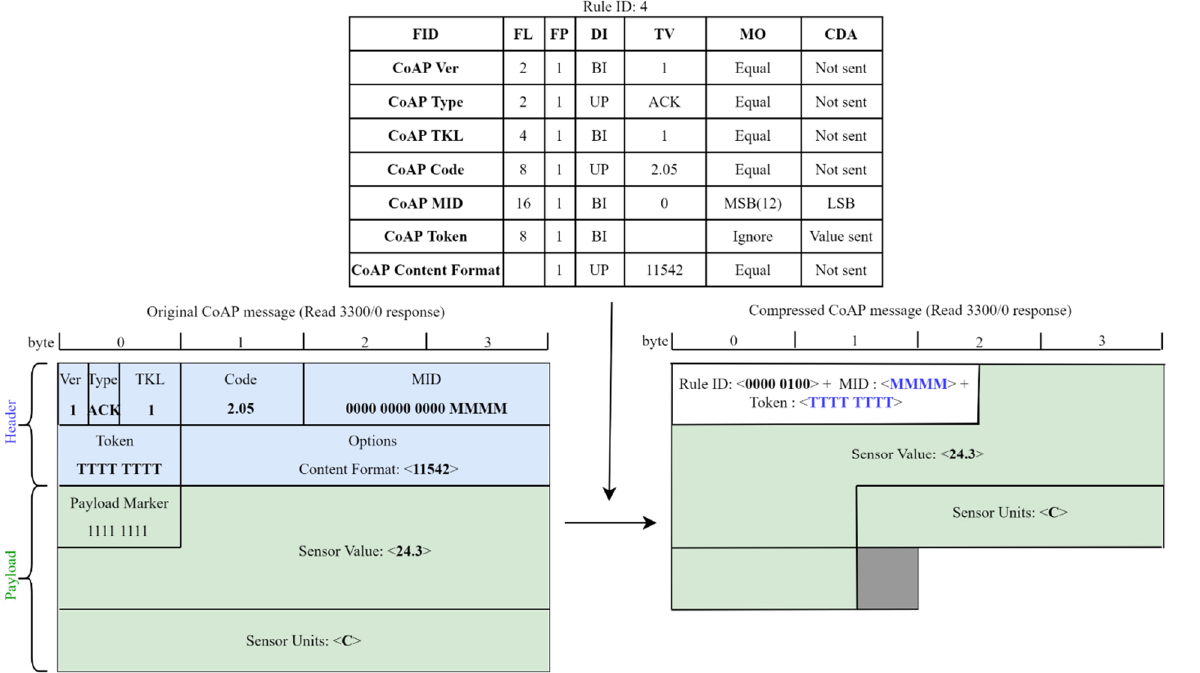
Figure 11. SCHC framework used in LoRaWAN.